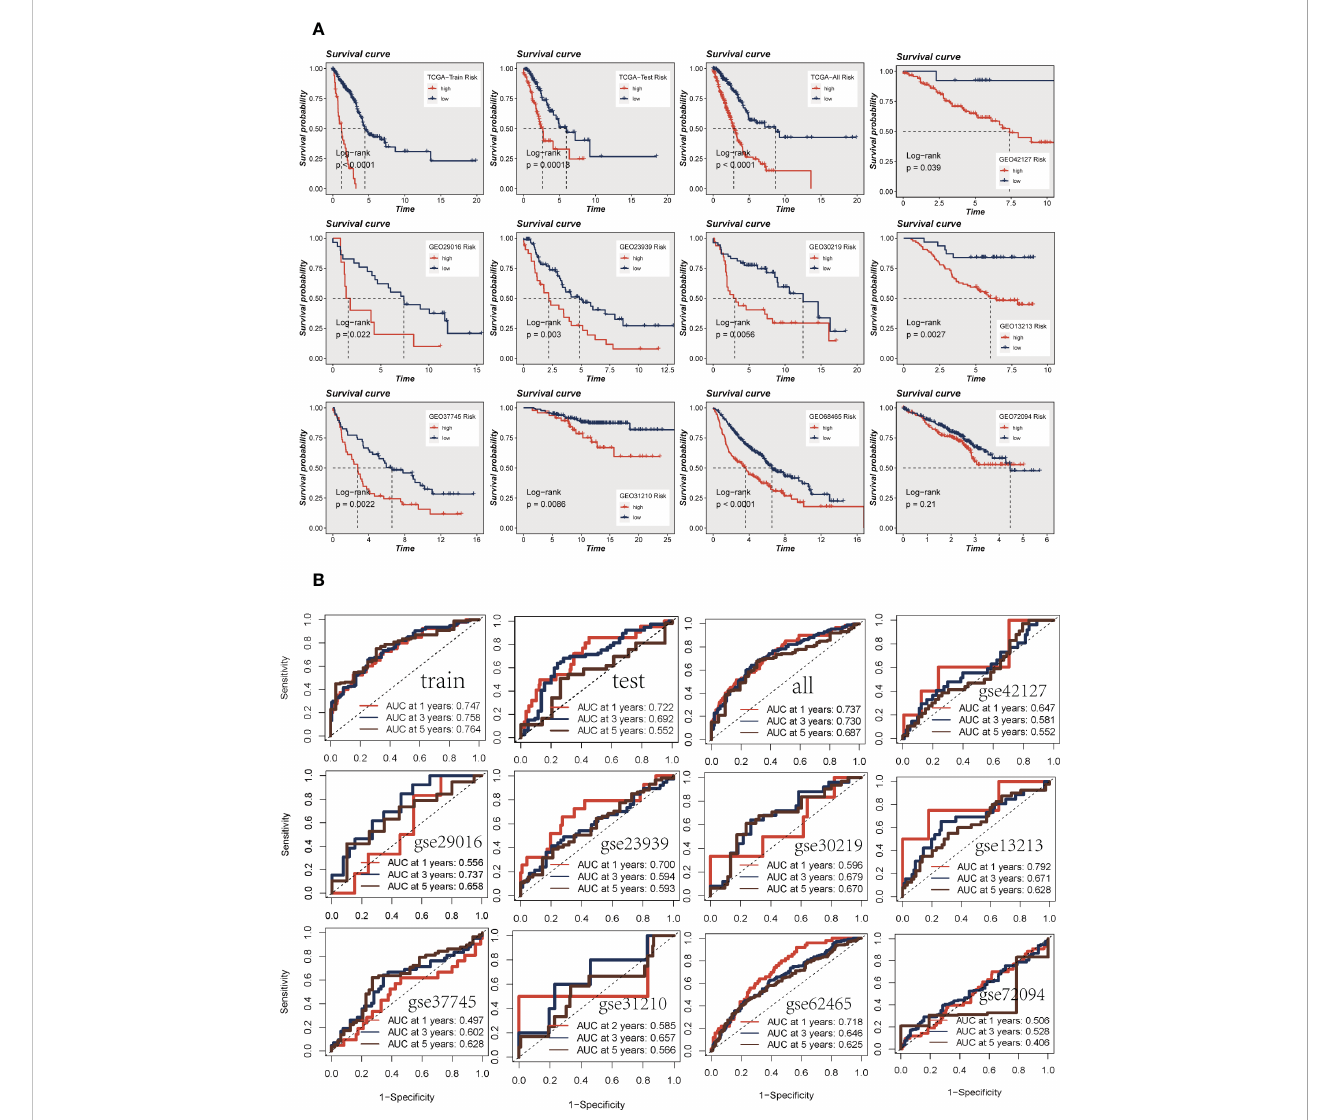
FIGURE 4 Assessment of risk models. (A) Kaplan-Meier prognostic analysis of signatures in the training, testing, whole TCGA, and nine GEO datasets. (B) The ROC curve was used to evaluate the performance of the model in the training, testing, whole TCGA, and nine GEO